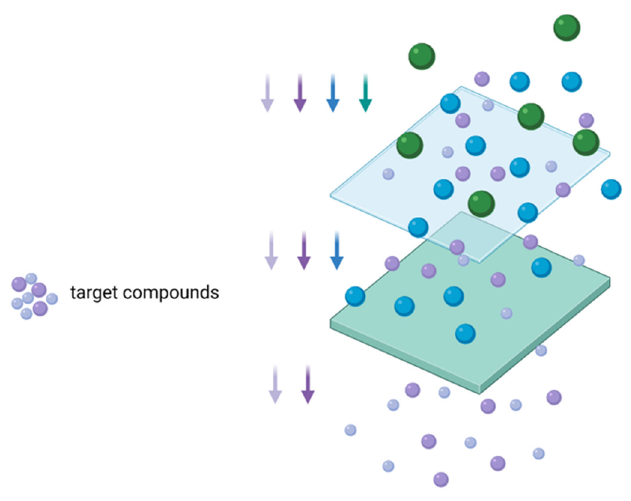
Figure 4. Membrane separation technology.